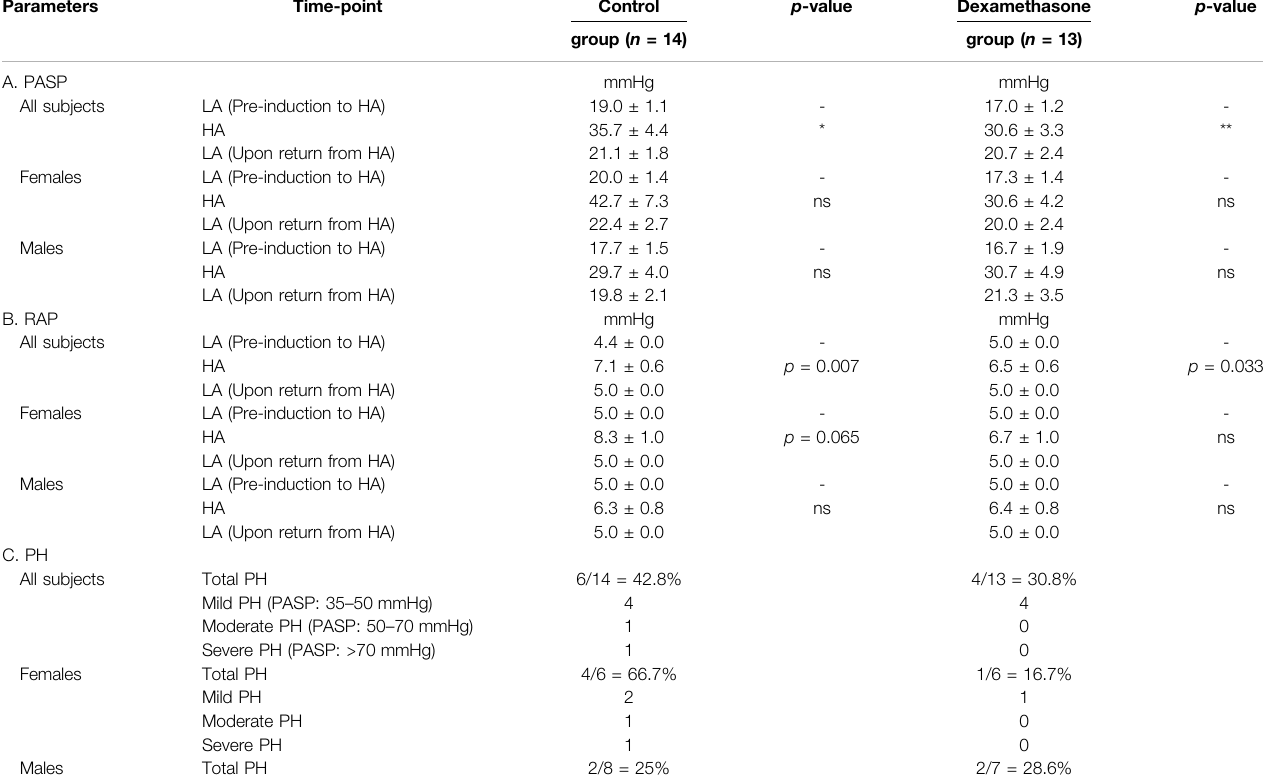
TABLE 2 | Echocardiogram parameters, PASP, RAP, and pulmonary hypertension at LA and HA in the control and the dexamethasone groups. Parameters